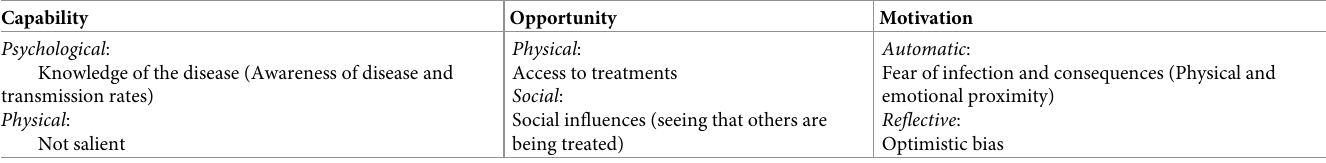
Table 1. Adapted list of factors that can influence antiviral drug uptake from [18].